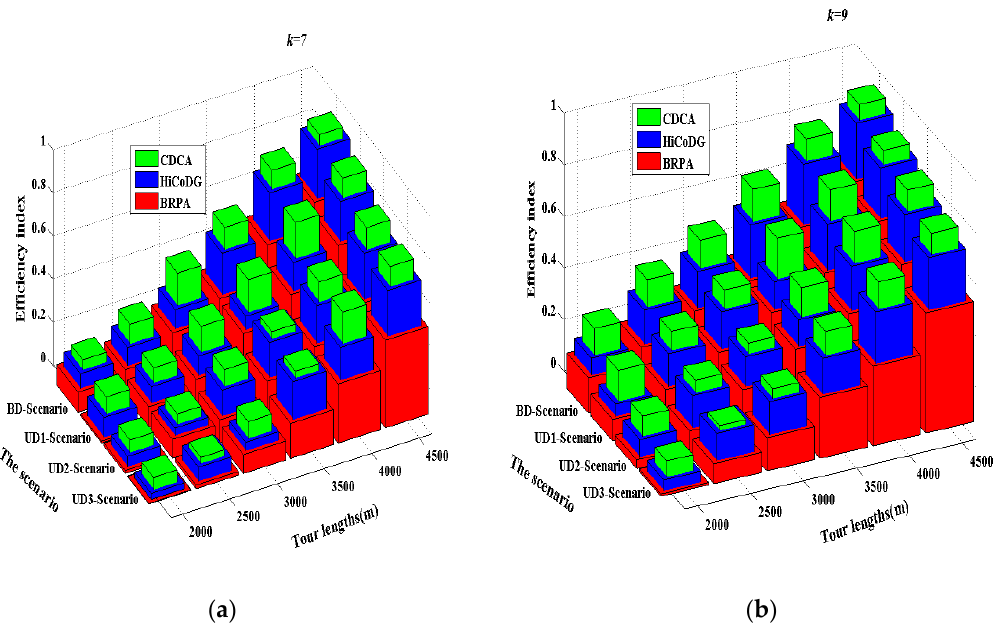
Figure 8. The comparison of efficiency index of three algorithms in four scenarios. ( a ) k = 7; ( b ) k = 9.